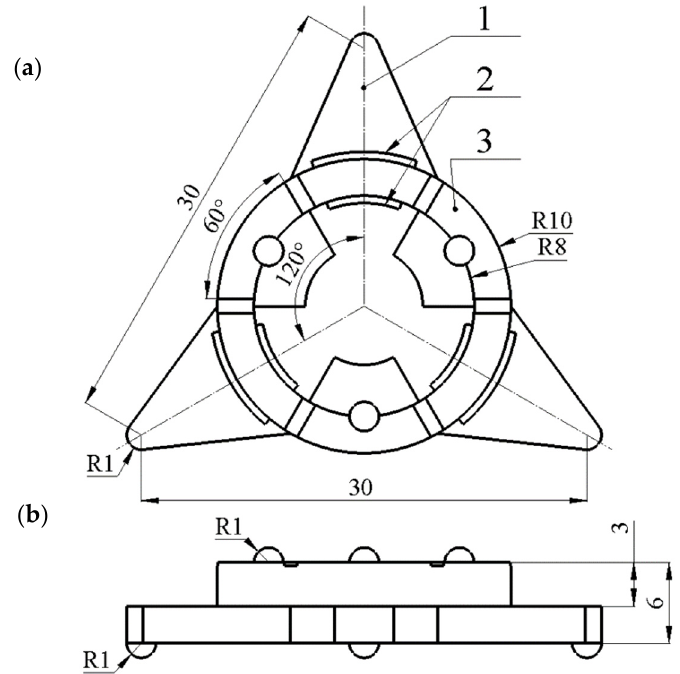
Figure 2. Geometrical parameters of the robot; ( a )—top view of the robot; ( b )—side view of the robot; 1—trapezoidal cantilever; 2—cuts for vibrations isolation; 3—segments formed on the top electrode of the piezo ceramic ring.